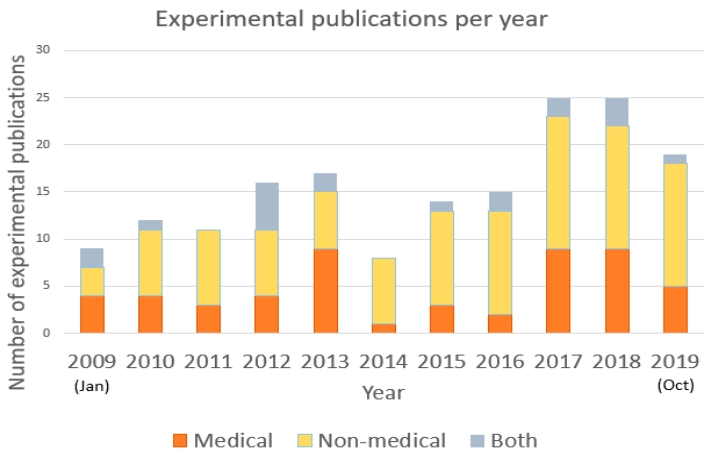
Figure 4. Experimental publications per year covering the period from January 2009 to October 2019. The publications have been further divided into medical or non-medical domain or both in case both domains have been covered.